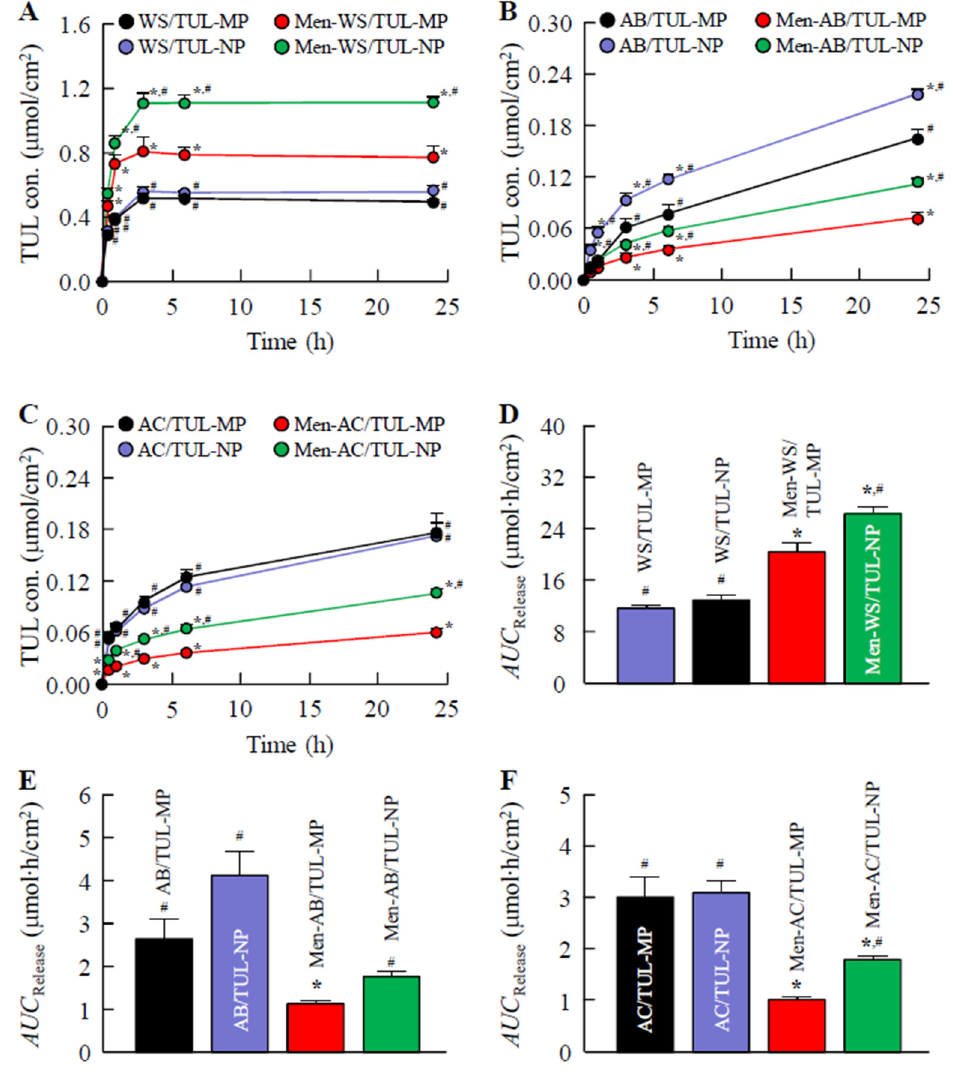
Figure 3. TUL release from ointments incorporating TUL-MPs and TUL-NPs through 450 nm pore membranes. Release of TUL from WS/TUL ( A ); AB/TUL ( B ); and AC/TUL ( C ) ointments with and without l -menthol through membranes. AUC Release of WS/TUL ( D ); AB/TUL ( E ); and AC/TUL ( F ) ointments with and without l -menthol through 450 nm pore membranes. The compositions of ointments incorporating TUL-MPs and TUL-NPs are presented in Table 1. Results are means ± SE; n = 6–10. * p < 0.05 vs. MP formulation for each category. # p < 0.05 vs. MP formulation with l -menthol for each category. The TUL release values from WS/TUL ointments were higher than those from AB/TUL and AC/TUL ointments, and the combination of NPs and l -menthol enhanced drug release from the WS base.